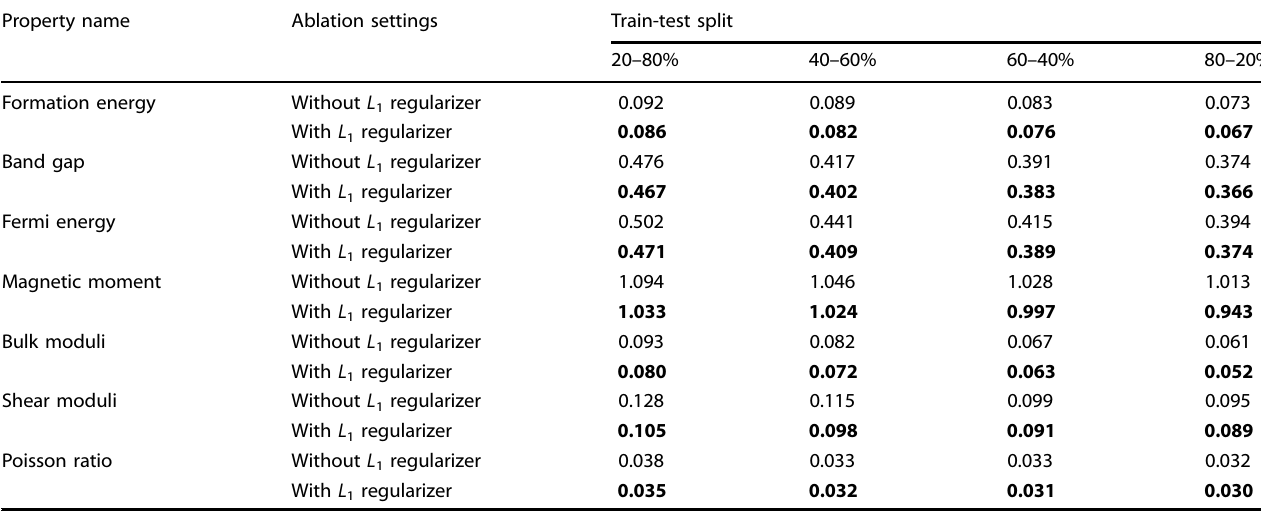
Table 6. Summary of experiments of ablation study on sparse feature selection using L 1 regularizer, performed on different train test splits across different properties